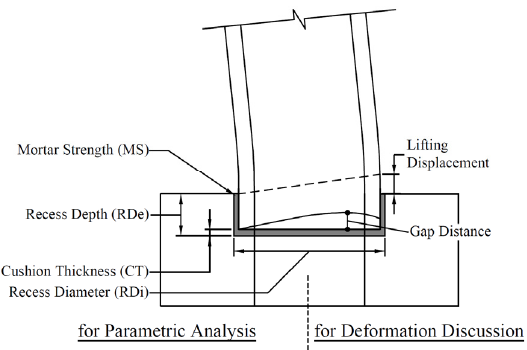
Figure 12. Illustration about joint deformation discussion (Section 3.3) and key parameter of recess. (Section 4).